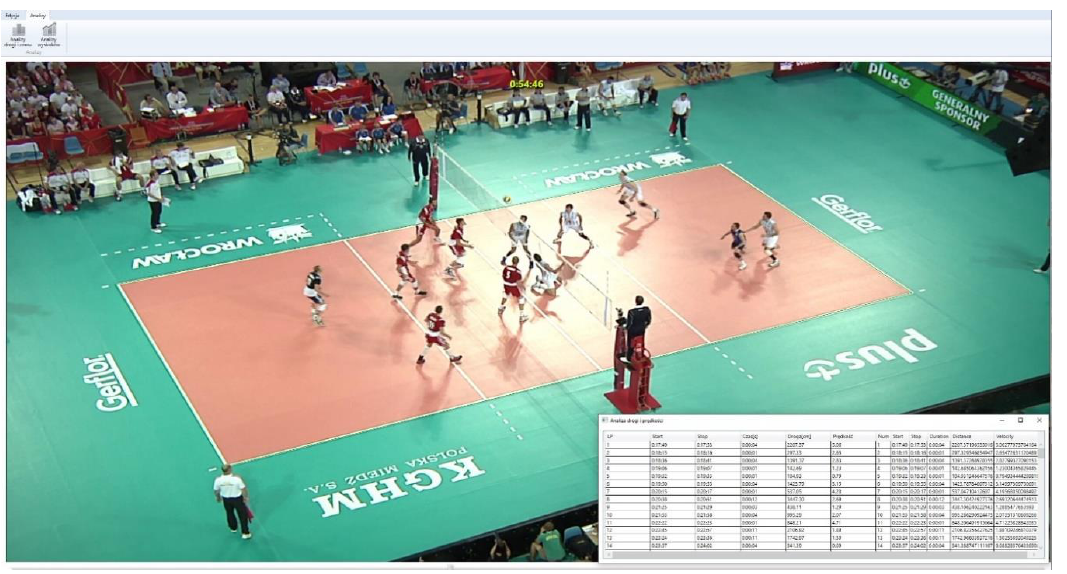
Figure 3. Software analysis on player covered distance.